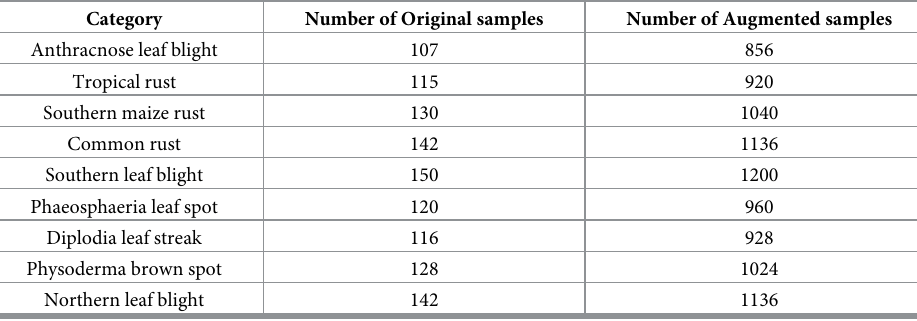
Table 2. Profile of sample images for nine types of diseases.